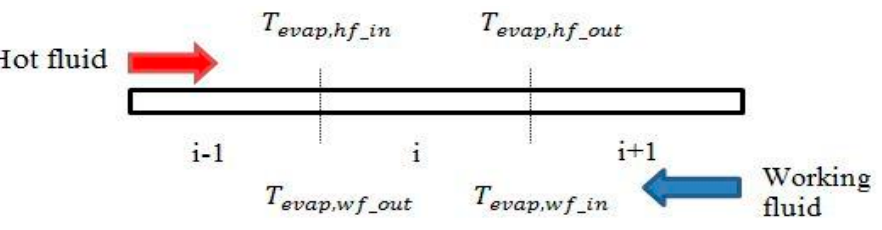
Figure 2. The evaporator discrete segments [35].